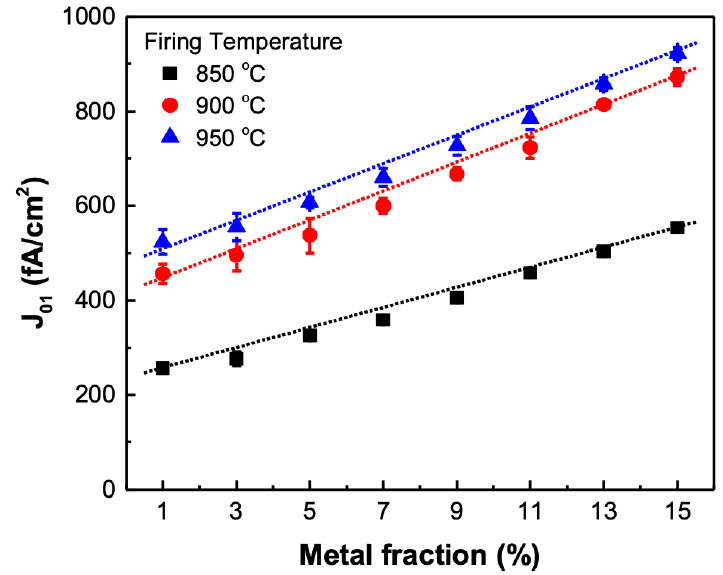
Figure 5. J 01 vs. the metal fraction on the front electrode